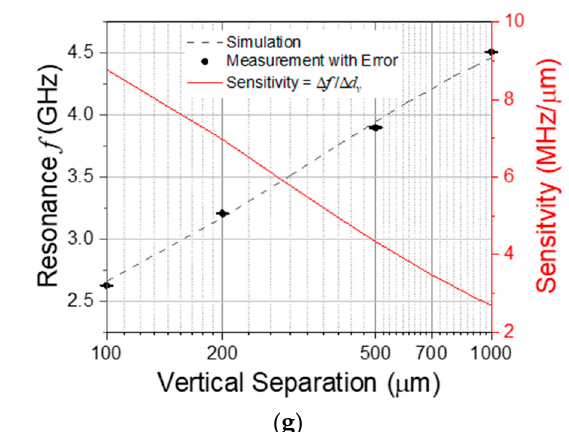
Figure 7. Fabricated static sensor, ( b ) schematic of vertical displacwment of the dynamic DSRR, ( c ) details of sub-2, measurement in ( d ) sideview, and ( e ) perspective, ( f ) transmission profile of the simulated sensor with respect to vertical separation, ( g ) agreement between simulation and measurement results on vertical displacement.